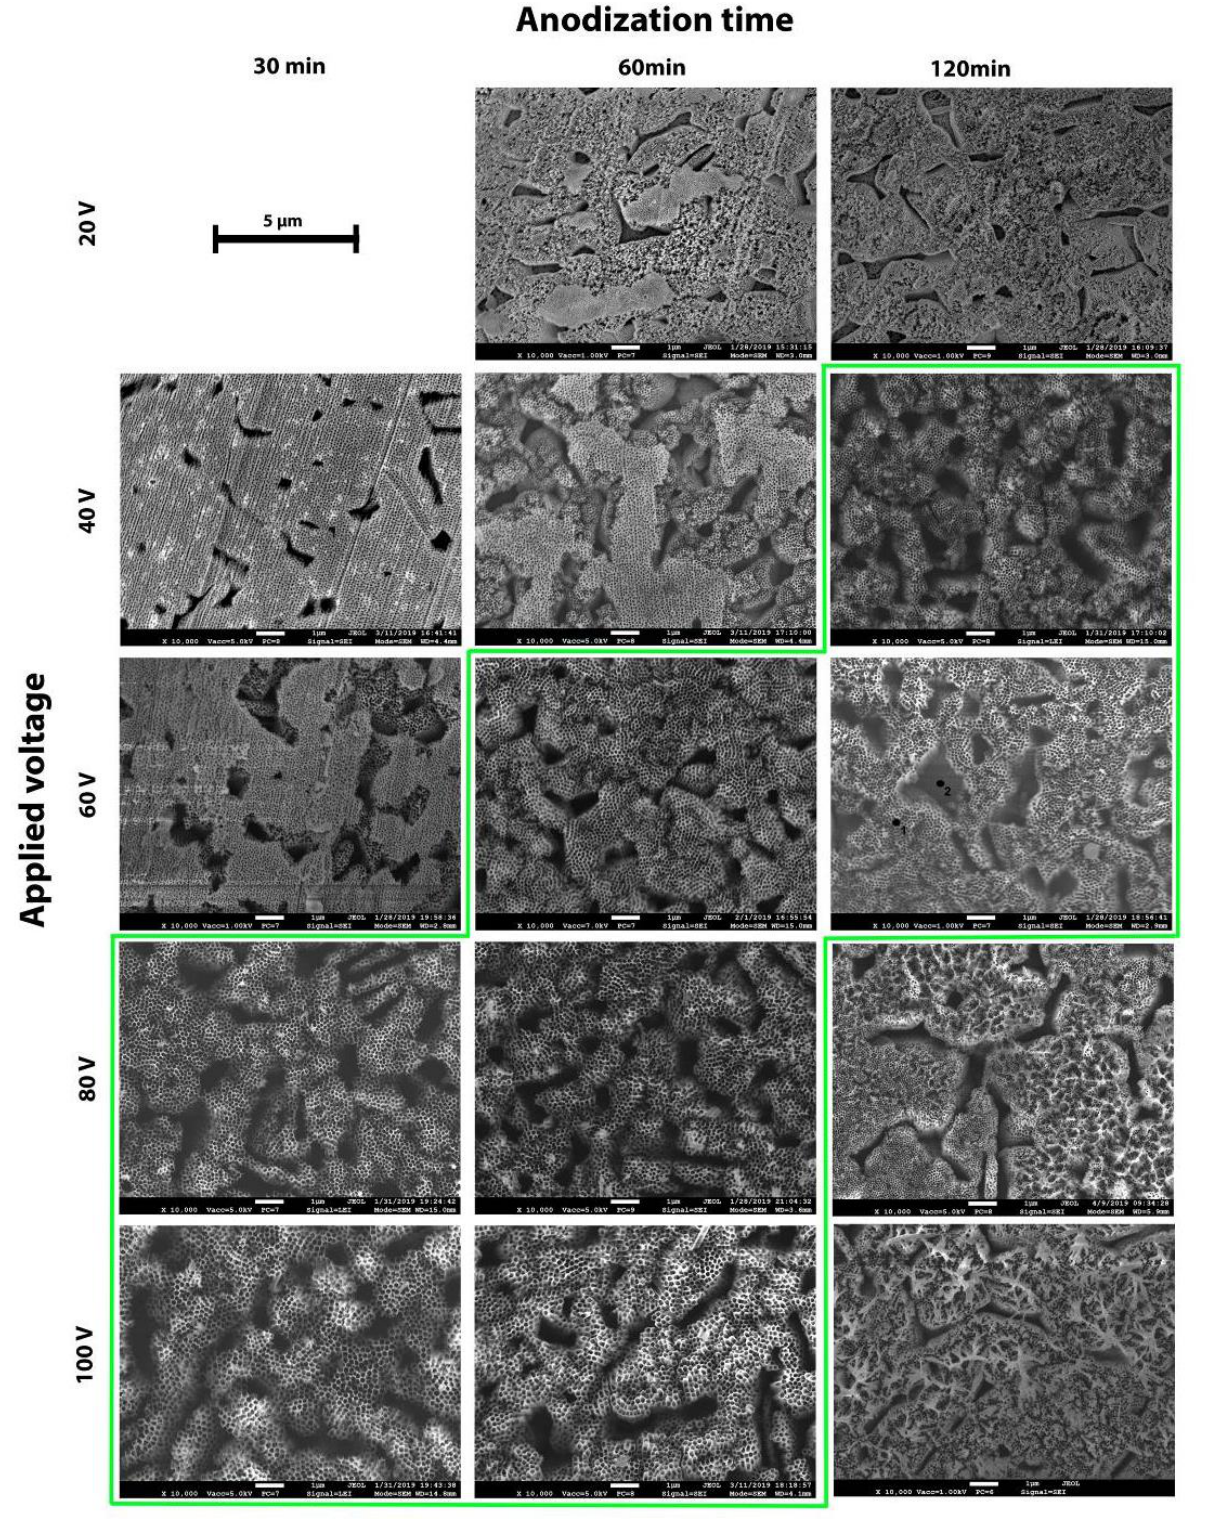
Figure 3. FESEM micrographs depicting a top-view of the anodic oxide layer produced through electrochemical anodization at different applied potentials and anodization times. The green frame shows the conditions with open-mouth nanotubes.